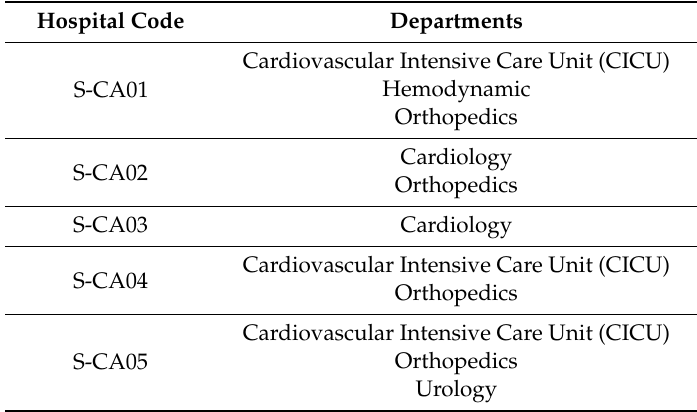
Table 2. Departments included in the study for each